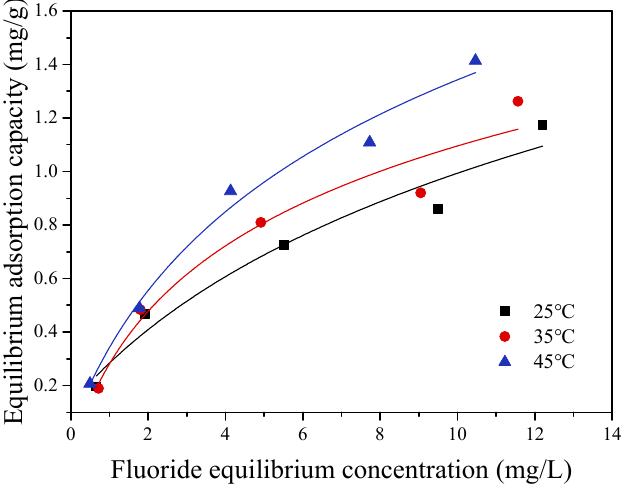
Figure 13. Adsorption isotherm curve of fluoride on MnOOH-supported AA. To get insight into the adsorption thermodynamic characteristics of MnOOH-supported AA, the Langmuir adsorption isotherm was used to analyze the defluorination properties; the results are shown in Figure 14. The related parameters of the Langmuir model and the Freundlich model at different temperatures are seen in Table 8. It may be thought that the adsorption process of MnOOH-supported AA on fluoride was well explained using both the Langmuir and Freundlich isotherms. However, fluoride adsorption was more suitable for the Freundlich model, with R 2 values of 0.9614, 0.9383 and 0.9852